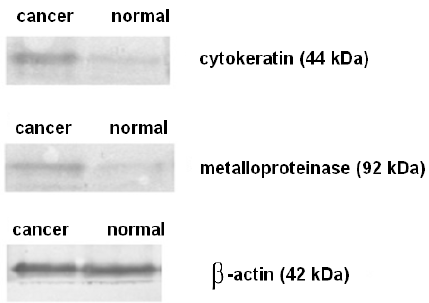
Figure 2. Western blot analysis of sentinel lymph node from the patient with metastatic breast invasive carcinoma NST G2 (same patient as in Figure 1). Left lane shows bands of cancer tissue while right lane shows bands of normal breast tissue. β -Actin was used as a control protein.